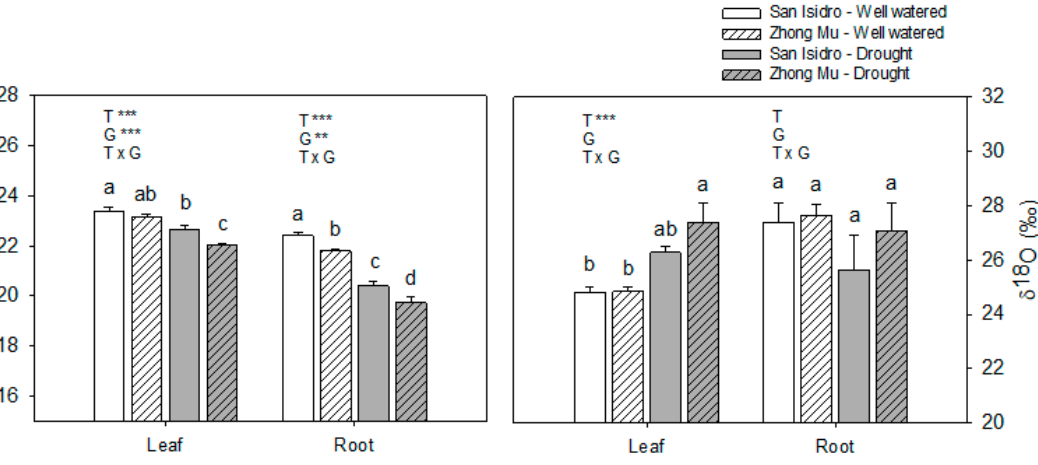
Figure 3. Carbon isotope discrimination ( ∆ 13 C) and oxygen isotope composition ( δ 18 O) in leaves and roots under control and drought condition in two cultivars of Medicago sativa : San Isidro and Zhong Mu. Each value represents the mean ± SE ( n = 6). The di ff erent letters indicate significant di ff erences ( p < 0.05). Asterisks indicate significant di ff erences: * p < 0.05, ** p < 0.01, *** p < 0.001, in the two-way ANOVA for water-stress and cultivars.